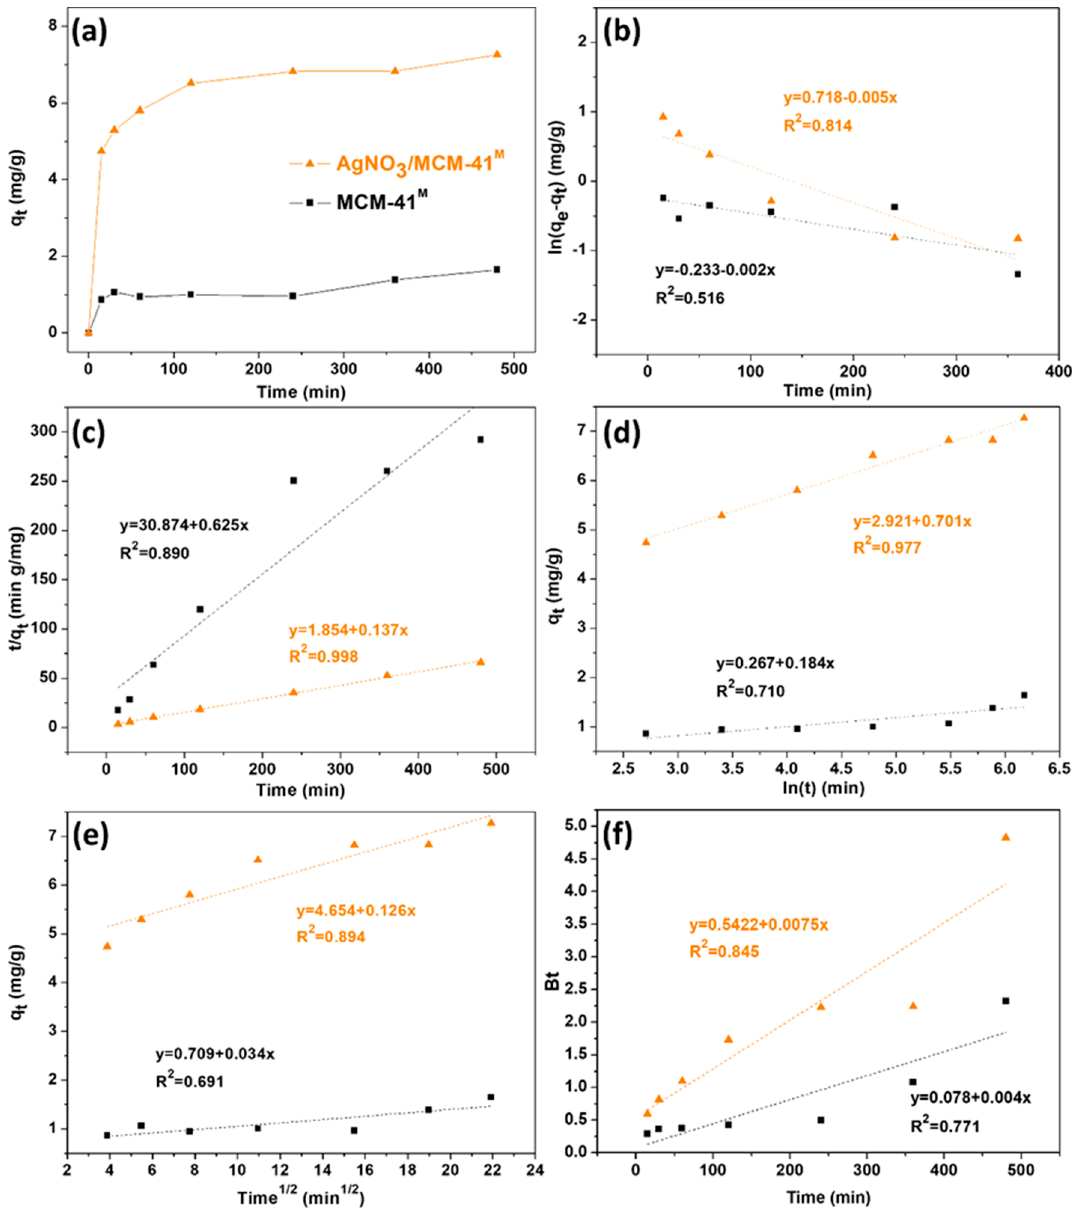
Figure 6. Plots of ( a ) contact time effect, ( b ) pseudo-first order, ( c ) pseudo-second order, ( d ) Elovich, ( e ) intraparticle diffusion and ( f ) Boyd models, where ▲ represents the kinetic data obtained for AgMCM-41 M and ■ represents the kinetic data obtained for MCM-41 M .